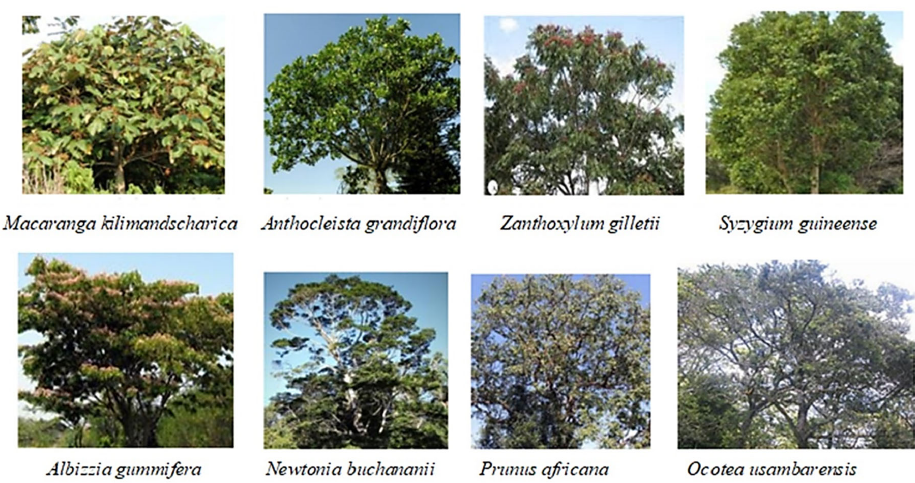
Figure 2. Samples of endangered tree species in the study area.